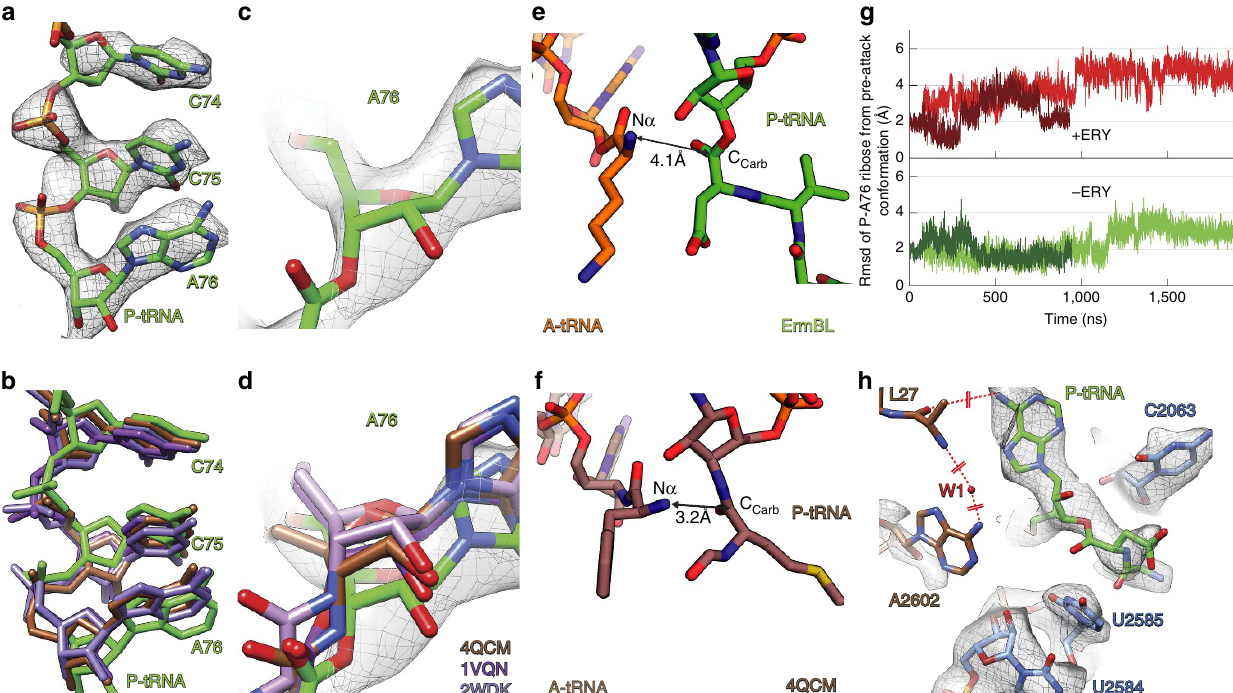
Figure 6 | Perturbation of the P-tRNA by ErmBL prevents peptide-bond formation. ( a – d ) Atomic model for the CCA end of the P-site tRNA (green) and ( a , c , d ) electron density (grey mesh) in the ErmBL-APE-SRC compared with ( b ) P-tRNAs in the pre-peptide-bond formation state (brown; PDB4QCM 32 ; blue, PDB2WDK 33 ), with ( c , d ) zoom onto the ribose of A76. ( e , f ) Relative orientation of the A-site a -amino group and the P-site carbonyl carbon in ( e ) ErmBL-APE-SRC and ( f ) the pre-catalysis state 32 . ( g ) Deviation of the ribose of A76 from the pre-attack state as a function of simulation time. ( h ) Conformation of the PTC in the ErmBL-SRC overlayed with the network of hydrogen bonds, creating a proton wire that enables peptide-bond formation. Cryo-EM map (grey mesh) with models for 23S rRNA (blue), L27 (brown) and P-tRNA